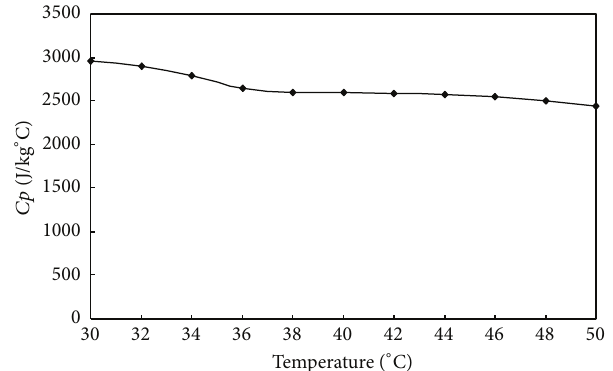
Figure 3: Specific heat versus temperature for